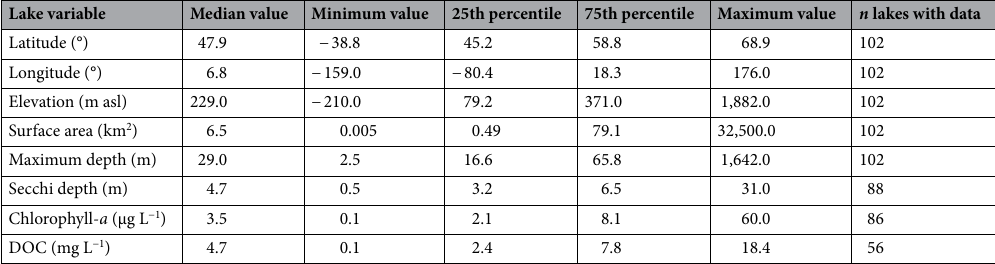
Table 1. Summary statistics of descriptor variables for the 102 lakes included in the analysis. Data from each individual lake are a single average for each variable, and do not include any temporal component. Values for each lake can be found in Supplementary Table S1